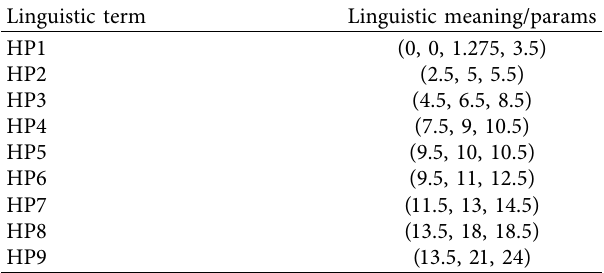
Table 4: Low PEEP linguistic terms used. Linguistic term